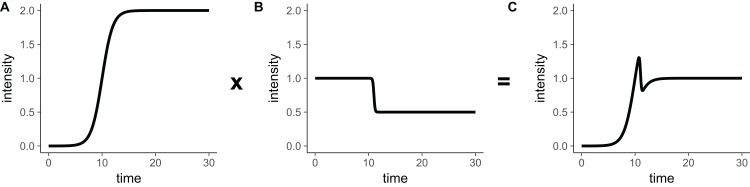
The product of a rising sigmoidal and a decaying sigmoidal (Eq. 14), is not guaranteed to be double-sigmoidal.For some parameter settings, when we multiply (A) the sigmoidal function (Eq. 8) and (B) the inverse sigmoidal (Eq. 13) function, we obtain (C) a result that is not double-sigmoidal. Parameter choices for this example are: Iinit = 0, Ifinal = 0.5, Imax = 2, a1 = 1, a2 = 10, tmid1 = 10, tmid2 = 11.